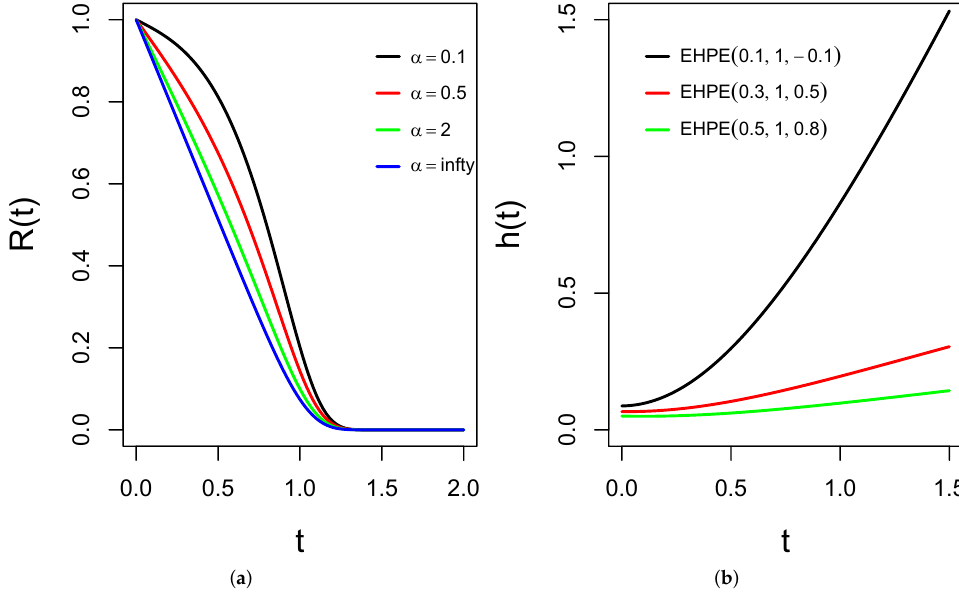
Figure 3. Reliability and hazard function for different values of α and β : ( a ) R ( t ) of EHPE ( α , δ = 1, β = − 0.75 ) ; ( b ) h ( t ) of EHPE ( α , δ = 1, β )